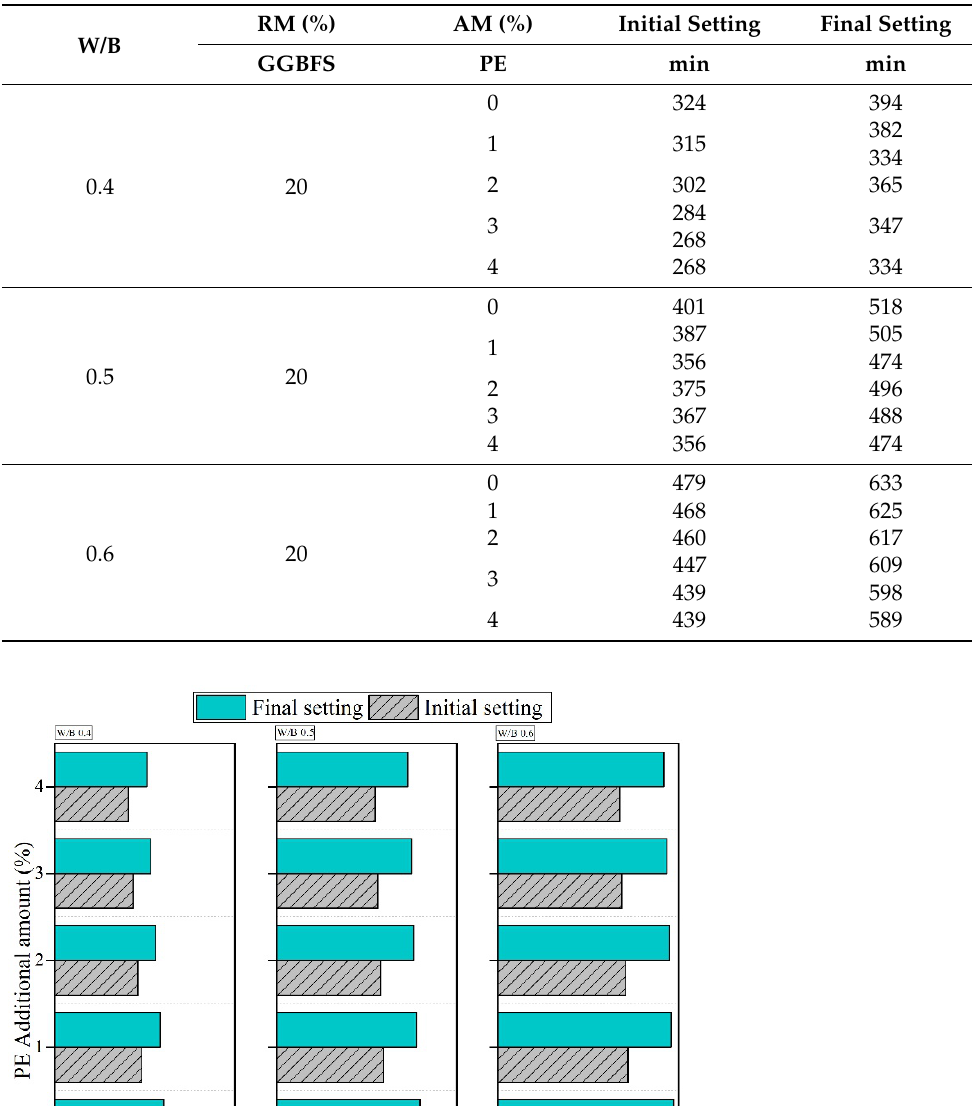
Table 6. Setting time of cement mortar with different W/B ratios and waste PE.